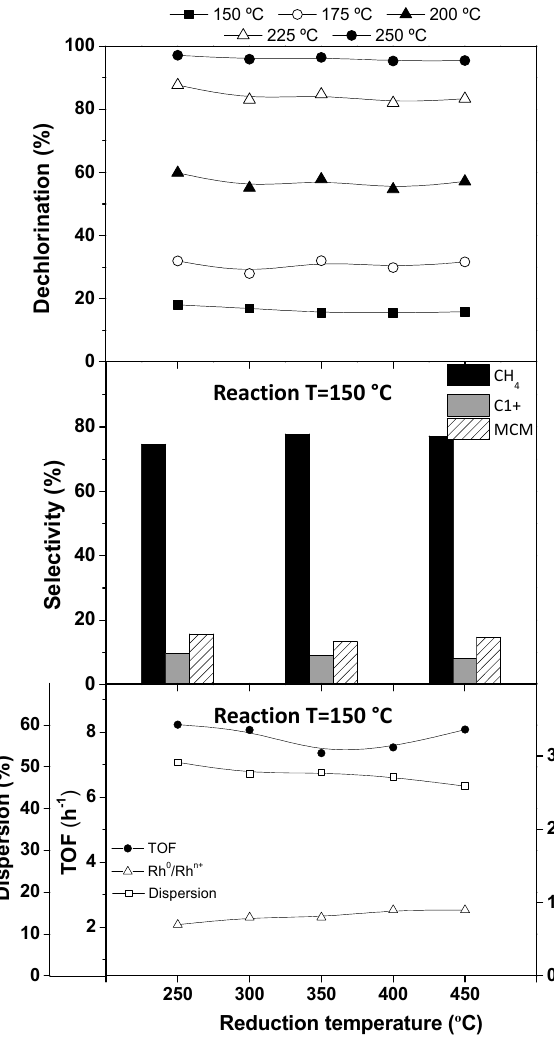
Figure 6. Results on the HDC of DCM within 150–250 °C reaction temperatures, at 0.6 kg cat ∙ h ∙ mol − 1 space ‐ time, with the Rh/C catalyst reduced at different temperatures.